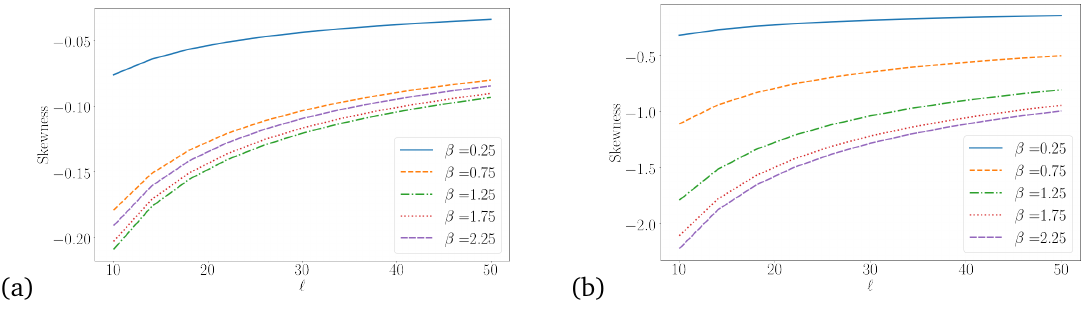
Figure 2: Skewness as a function of (cid:96) for several values of β at (a) h = 0.5 and (b) h =